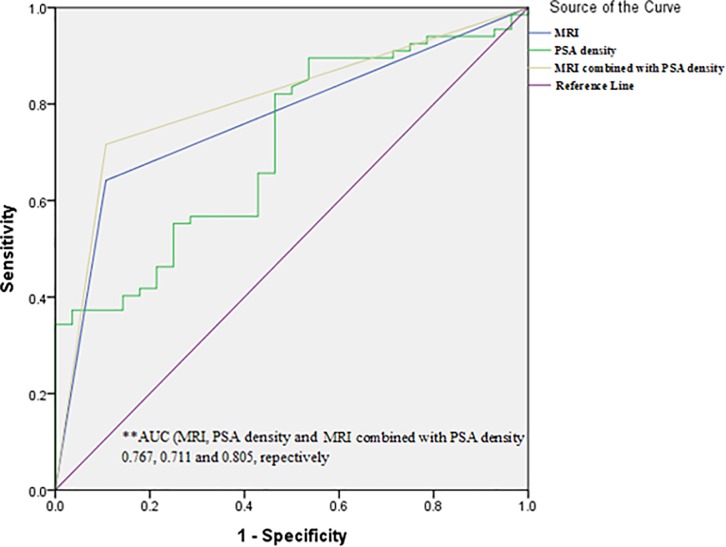
Receiver operating characteristic curves of MRI, PSA density, and MRI combined with PSA density for predicting the presence of residual tumor (pT0).